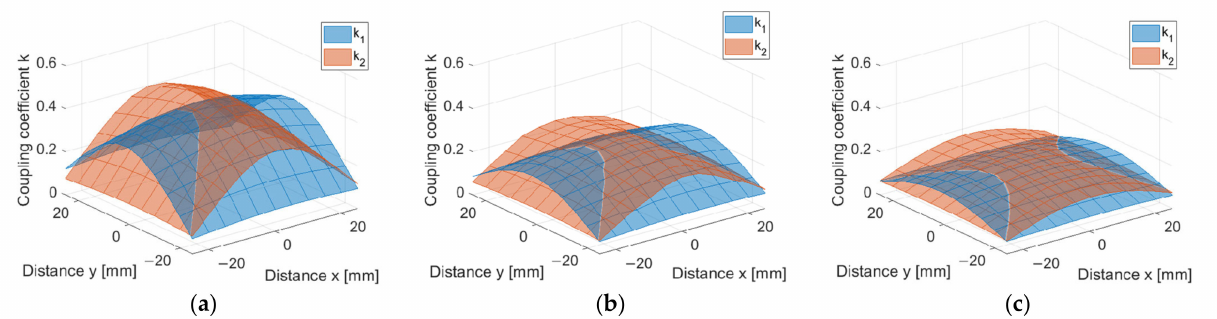
Figure 10. Double DD x - y plane coupling coefficient measurements: ( a ) 15.3 mm distance between the pads; ( b ) 25.3 mm distance between the pads; ( c ) 35.3 mm distance between the